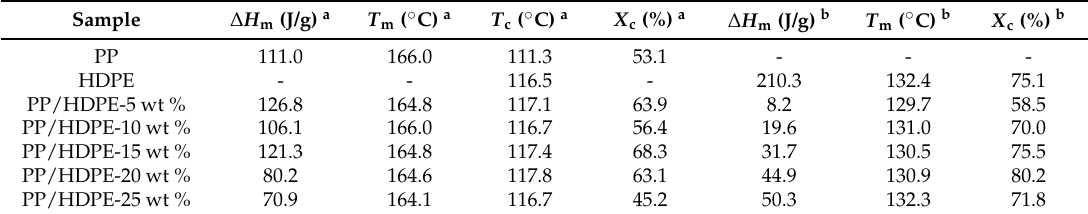
Table 1. Differential scanning calorimetry (DSC) data of polypropylene/high density polyethylene (PP/HDPE) polyblends.